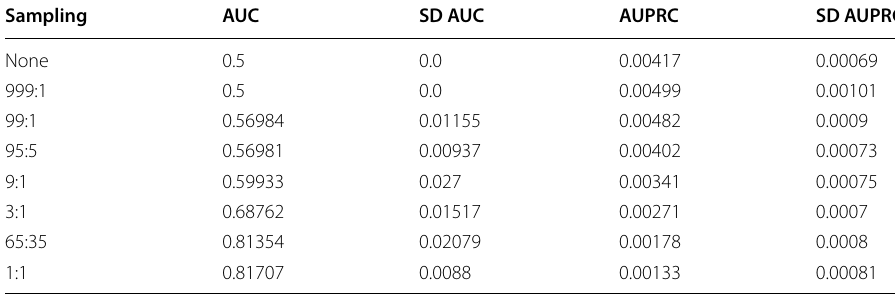
Table 9 Results for Logistic Regression